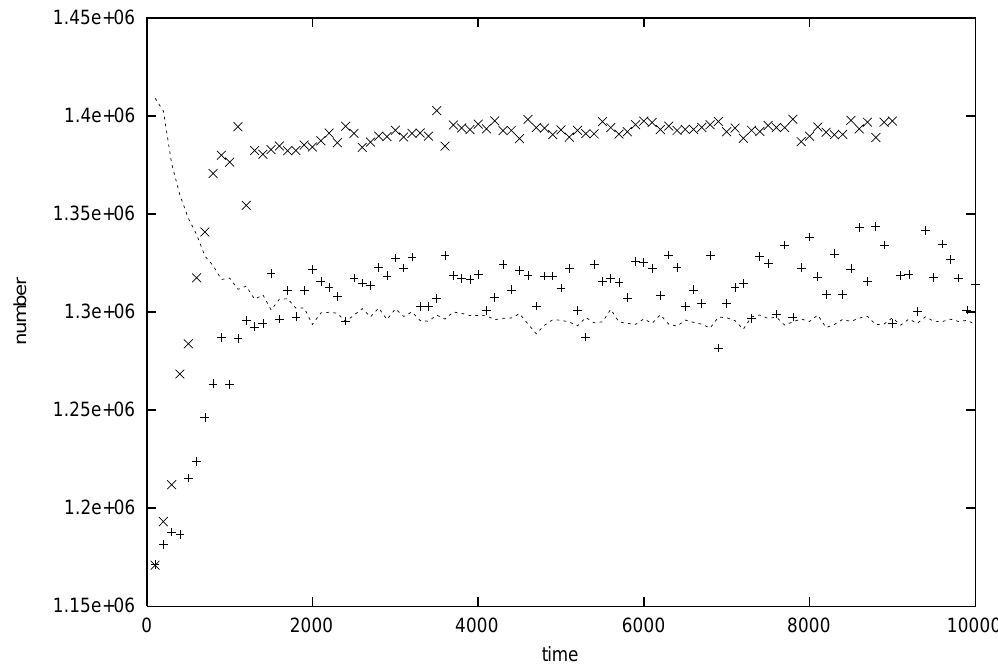
Fig. 4 – Comparison of populations, versus number of iterations, for SX with child protection (+,x), and AS (line). (For the data marked by x, females select only male partners with at most one active bad mutation.) N max = 5 million; otherwise parameters as in Fig.